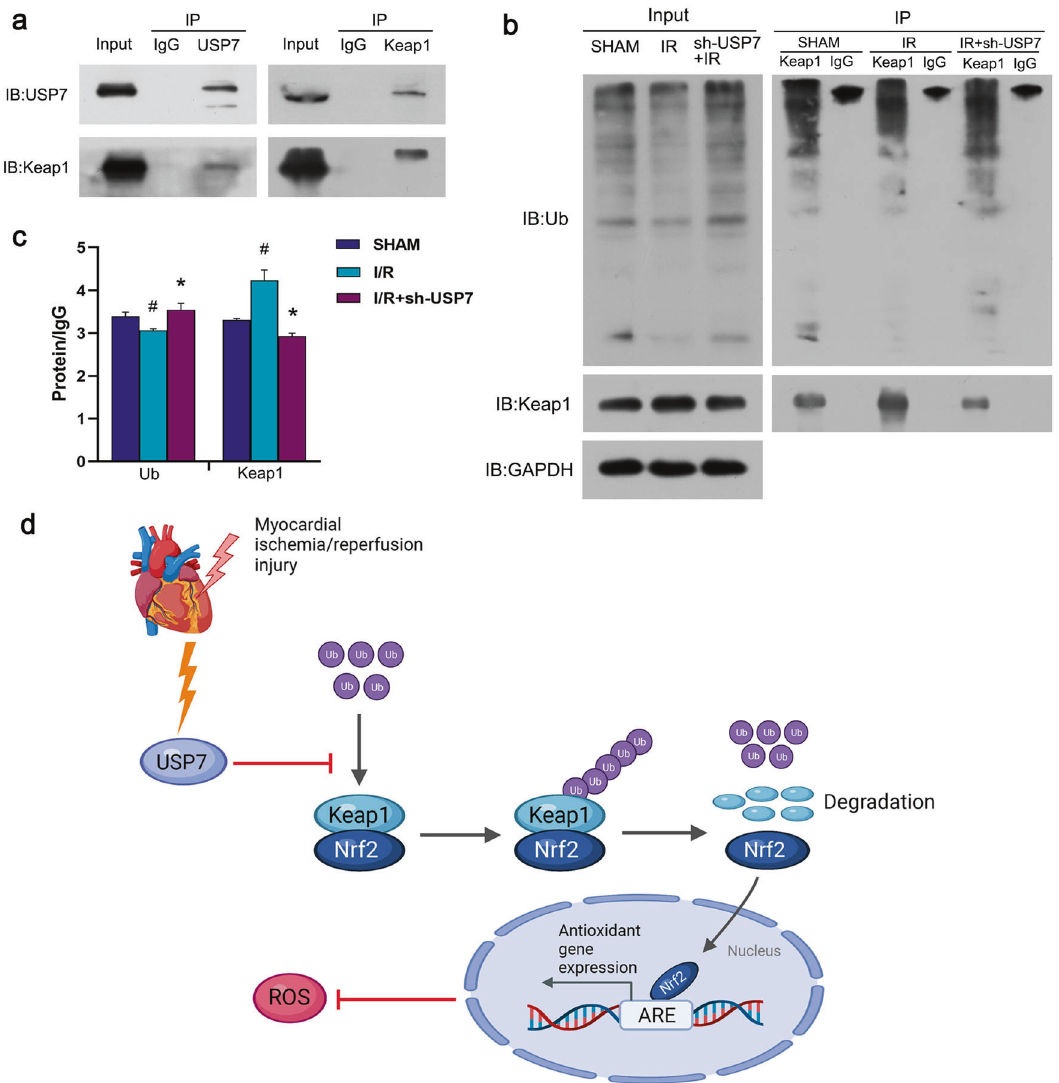
Fig. 7 USP7 regulates myocardial ischemia/reperfusion by deubiquitinating and stabilizing Keap1. a After 30 minutes of ischemia and 2 h of reperfusion, the mouse heart tissue was taken for Co-IP. USP7 ’ s interaction with Keap1 was investigated using Western blot. b Co-IP was performed with Keap1, then immunoblotted with antibodies against ubiquitin (Ub) and Keap1. b sh-USP7 was injected into the myocardium of mice, and the myocardial ischemia/reperfusion model was established 7 days later. Immunoblot was used to determine the amounts of ubiquitin (Ub) and Keap1 proteins. c Co-IP was performed with Keap1 and IgG, then immunoblotted with antibodies against Ub and Keap1. Quantitative analysis statistics are shown. d A proposed mechanism for USP7 to regulate myocardial ischemia/reperfusion via stabilizing the Keap1 level. (Created with